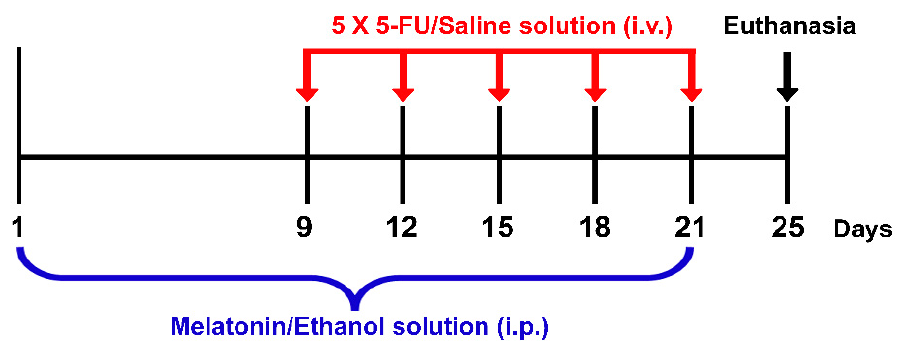
Figure 1. Timeline of drug administration. Red arrows represent each single intravenous (i.v.) injection of a 5-FU/Saline solution. The blue bracket represents the period of time for intraperitoneal (i.p.) injections of a melatonin/ethanol solution. Animals were killed and the brains were removed on day 25 as shown by the black arrow.